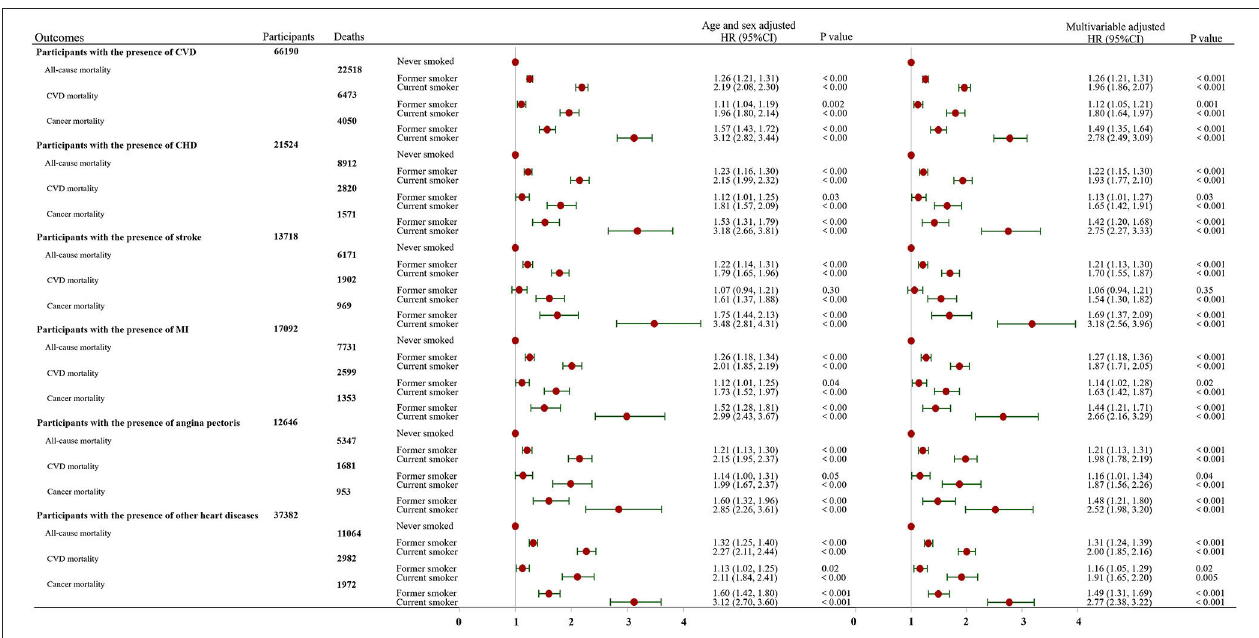
FIGURE 1 | Association of smoking status with all-cause, CVD and cancer mortality stratified by the presence of cardiovascular disease. The multivariable-adjusted model was adjusted for age, sex, race, education, income, body mass index, physical activity, alcohol intake, baseline hypertension, diabetes and cancer variables. CI, confidence interval; HR, hazard ratio; CVD, cardiovascular disease; CHD, coronary heart disease; MI, myocardial infarction.